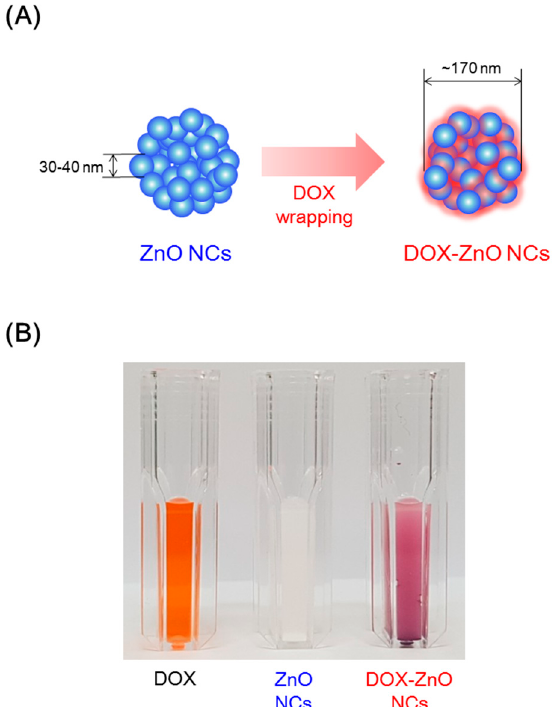
Figure 1. Development strategy of doxorubicin-wrapped zinc oxide nanoclusters (DOX-ZnO NCs). ( A ) Fabrication scheme of DOX-ZnO NCs; ( B ) Images of doxorubicin (DOX) solution, ZnO NCs dispersion, and DOX-ZnO NCs dispersion in distilled water (DW). DOX HCl, ZnO NCs, or DOX-ZnO NCs, corresponding to 10 mg/mL DOX-ZnO NCs concentration, were dissolved or dispersed in DW.